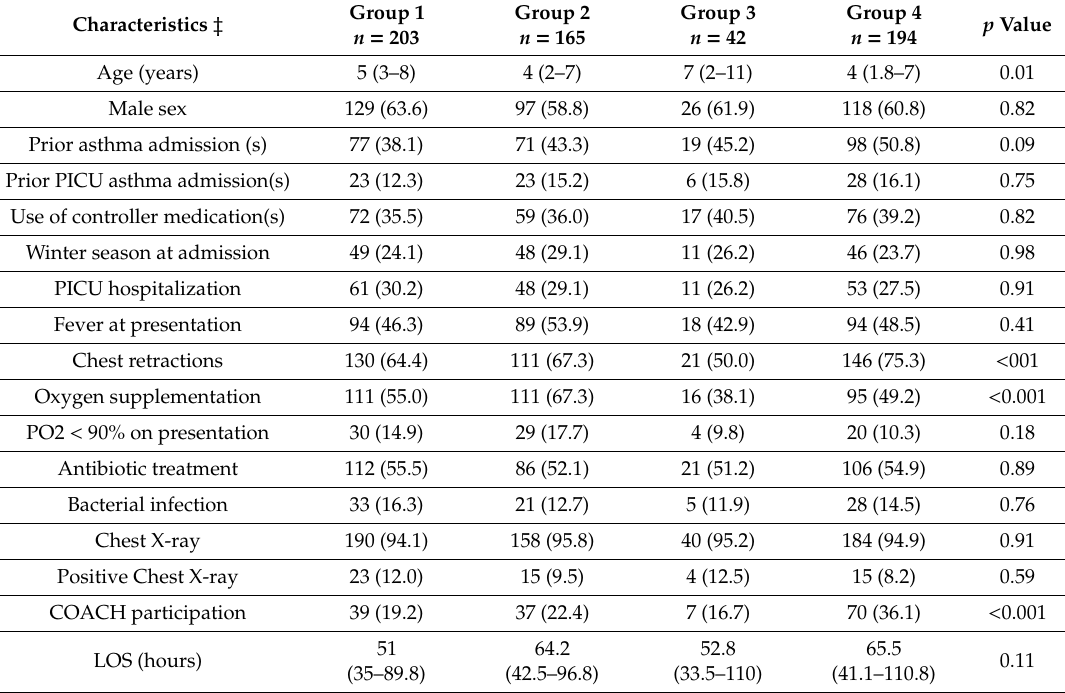
Figure 1. Distribution of type of health insurance coverage based on race/ethnicity. Table 1. Comparison of patients’ demographic and clinical characteristics by Group †.